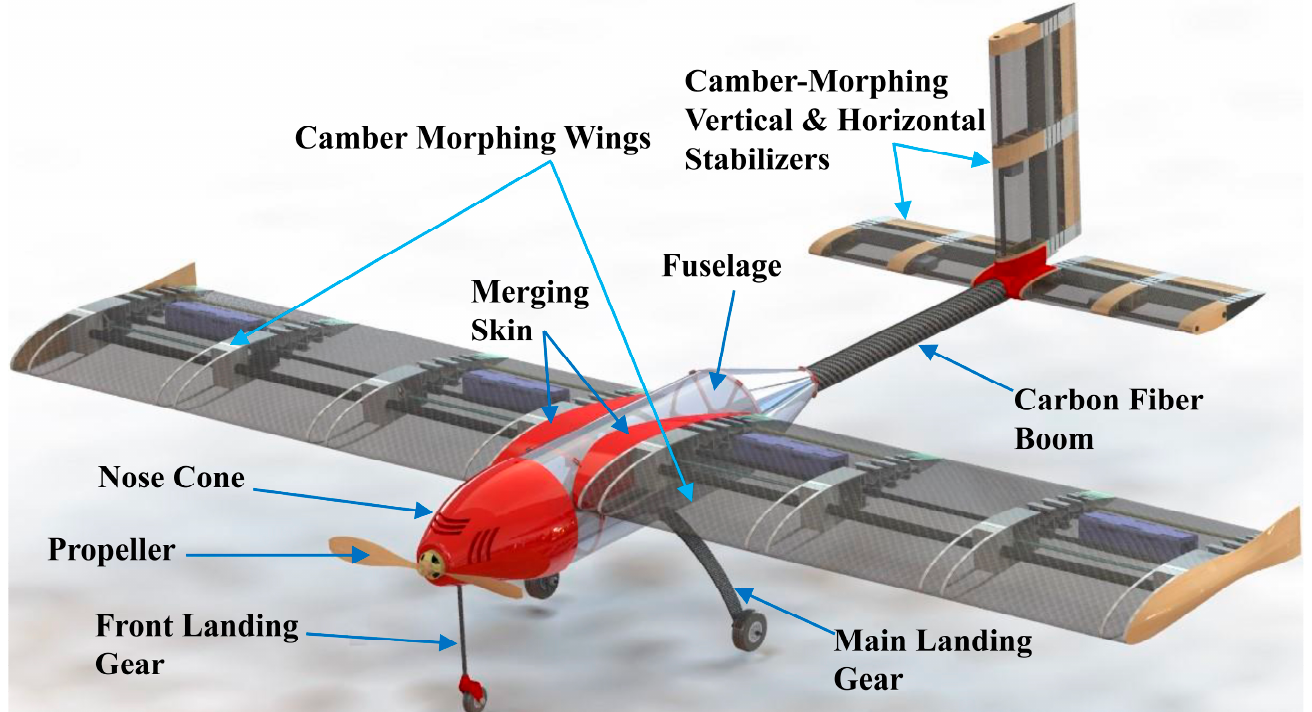
Figure 6. Full CAD model of MataMorph-3 (MM-3) .